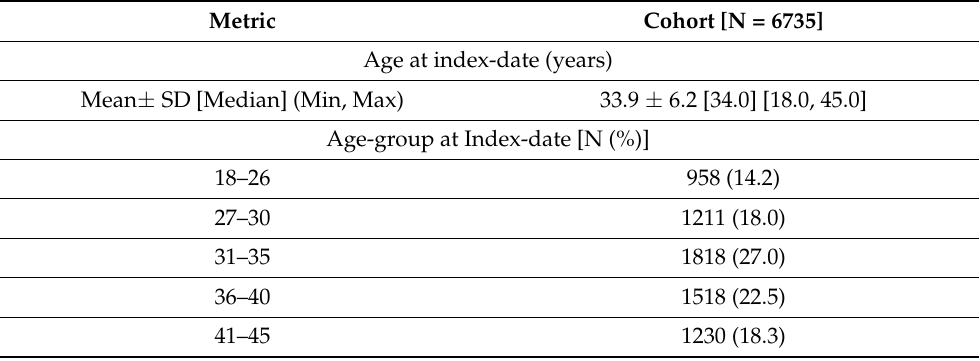
Table 1. Baseline